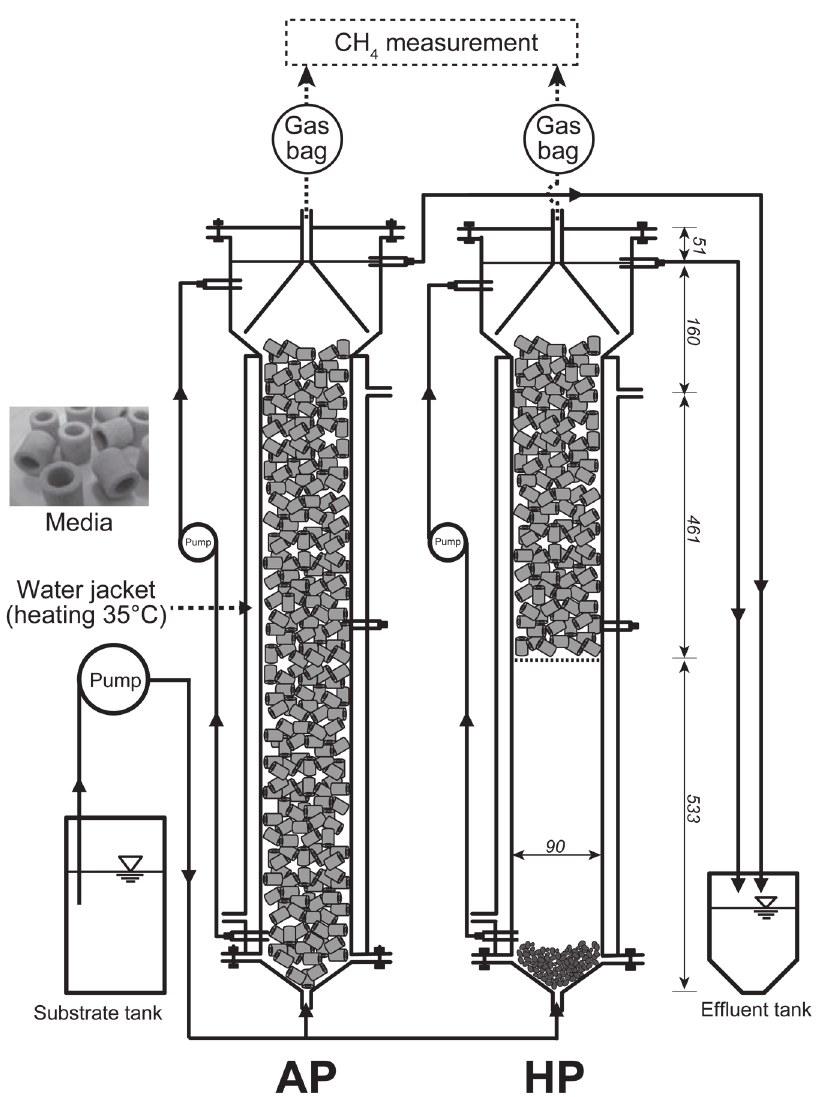
Fig 1. Cross-section illustration of the anaerobic packed-bed (AP) and hybrid packed-bed (HP) reactors. The reactors were equipped with water jacket and heated by water heater to kept at 35°C. The numbers in italics indicate size